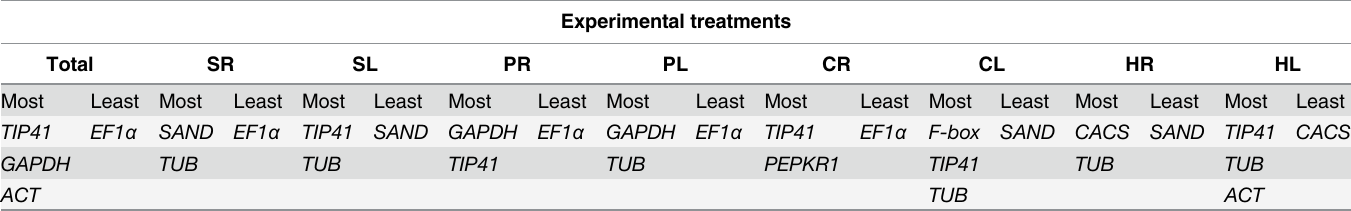
Table 5. Most stable and least stable combination of reference genes based on RefFinder analysis. Experimental treatments